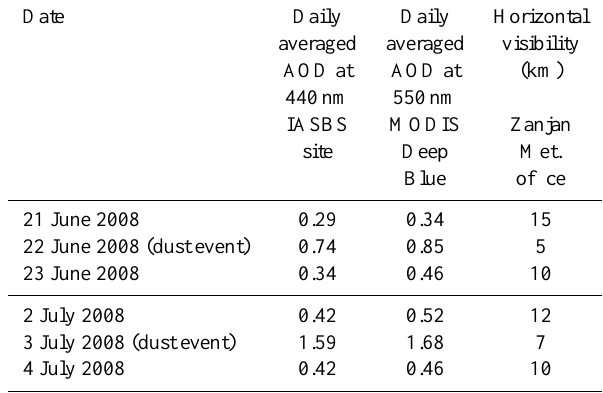
Table 1. Two typical dust events recorded on 22 June 2008 and 3 July 2008. The AOD values were extracted from MODIS Deep Blue data and the IASBS site